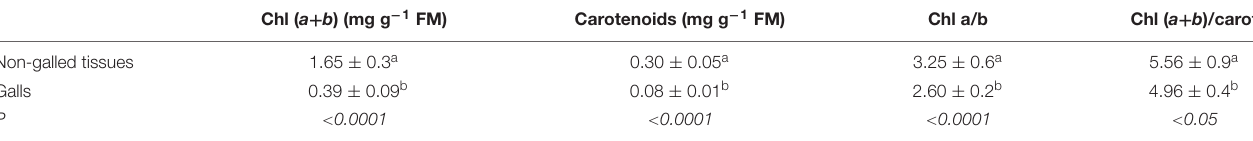
TABLE 2 | Photosynthetic pigment content (means ± standard deviation, n = 30) in Matayba guianensis leaflets and galls induced by Bystracoccus mataybae